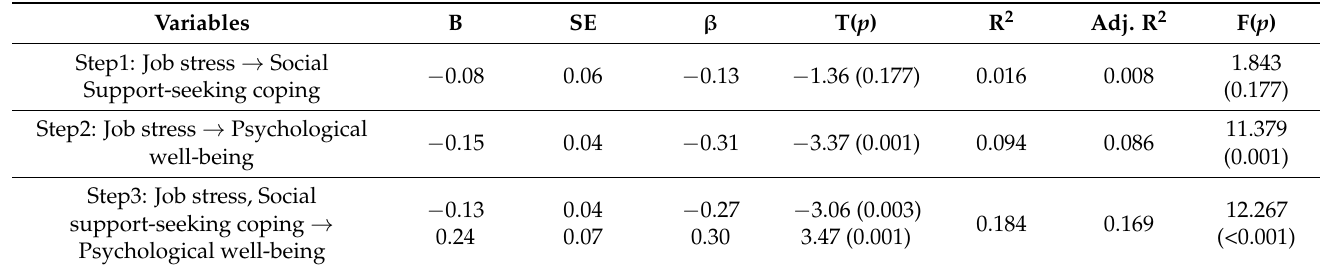
Table 5 provides the mediating effect of social support-seeking coping in the relation- ship between job stress and psychological well-being of the participants. Table 5. Mediating effects of social support-seeking coping in the relation between job stress and psychological well-being in participants.